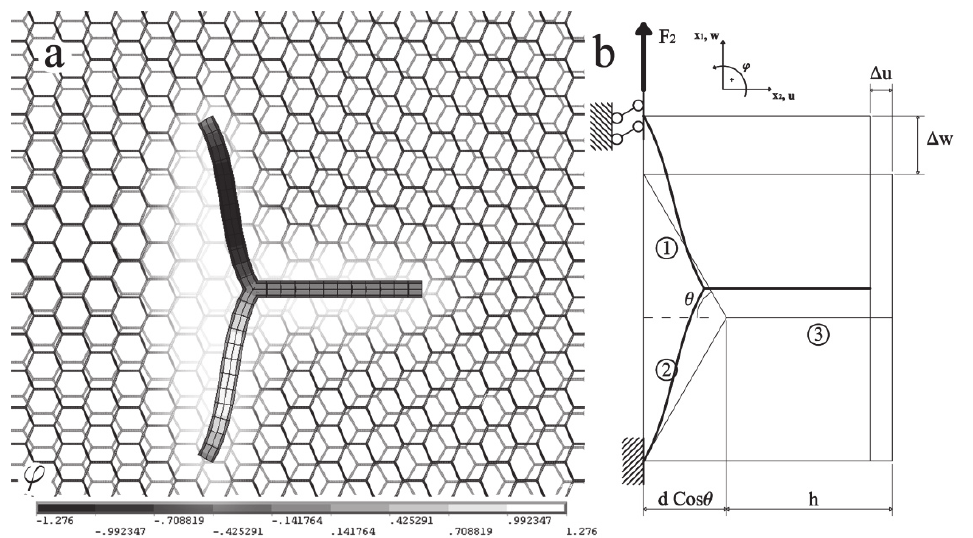
Figure 8: Hexagrid - axial test along x 1 ; a) deformed configuration; b) definition of the